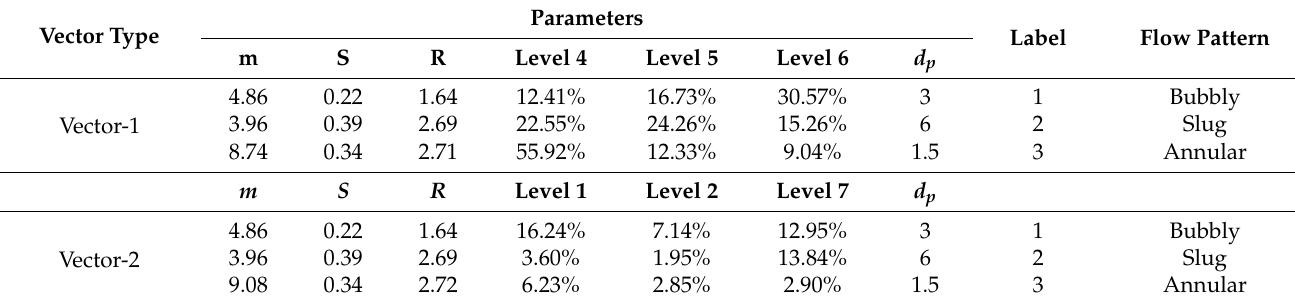
Table 7. Examples of vectors with different